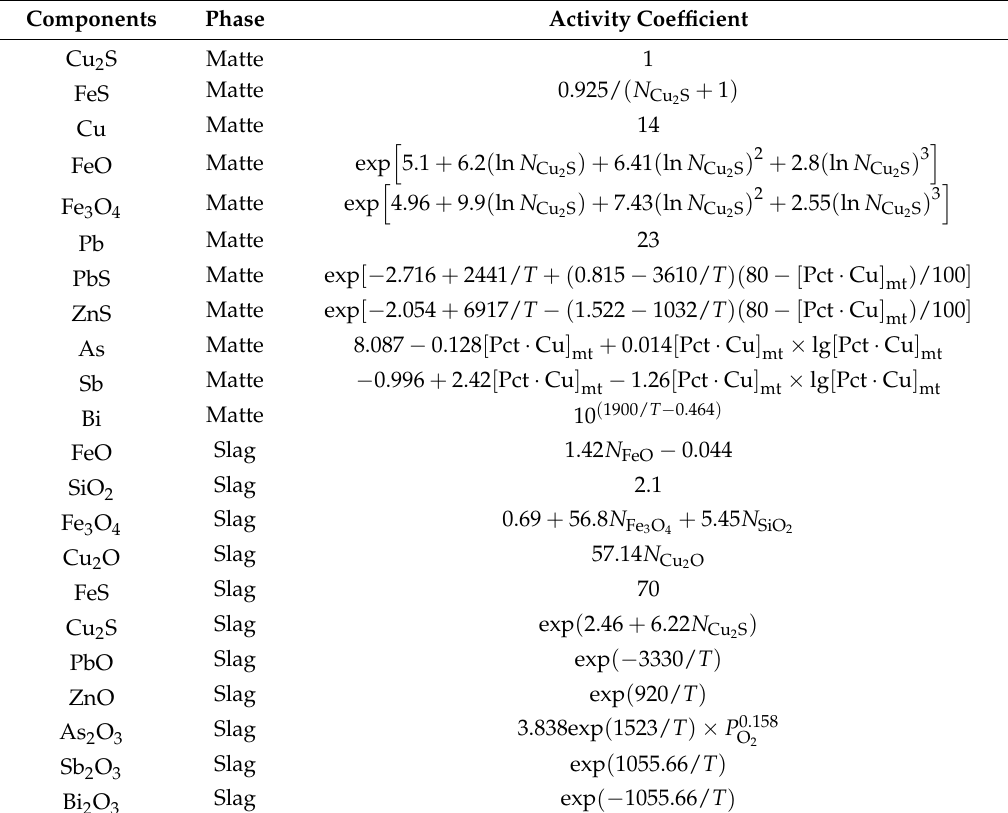
Table 2. Phase entrainment coefficient in the SKS process.